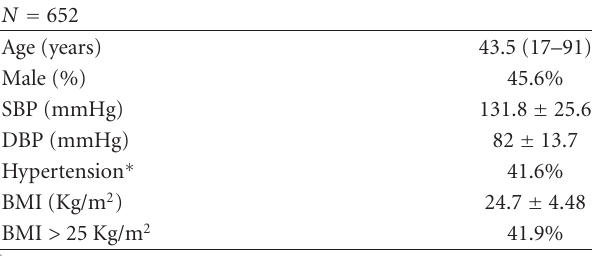
Table 1: Descriptive statistics of 652 individuals from 12 quilombo populations regarding to studied